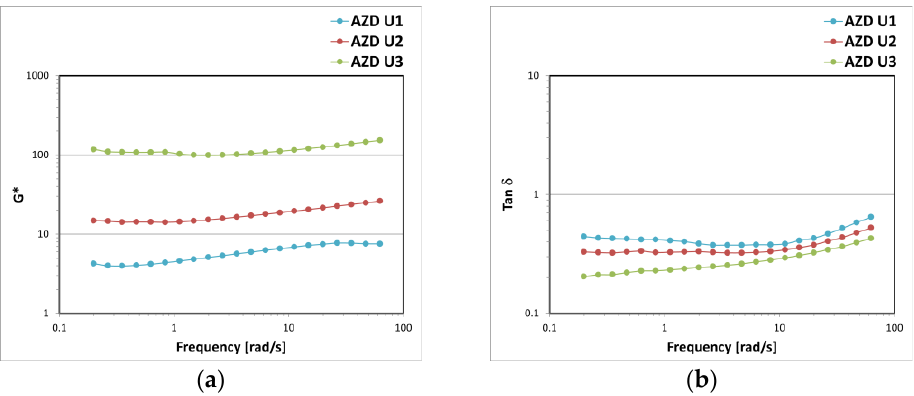
Figure 15. Complex G* modulus ( a ) and damping factor tan δ ( b ) trend as a function of the oscilla- tion frequency for the emulsions prepared with A-Z associations (ratio 1:1) at a total solid amount of 10% w/w, D at 0.1% w/w, and increasing amounts of a mixture of filters U (AZD U1 with 9% w/w of U; AZD U2 with 15-% w/w of U; AZD U3 with 23.5% w/w of U).